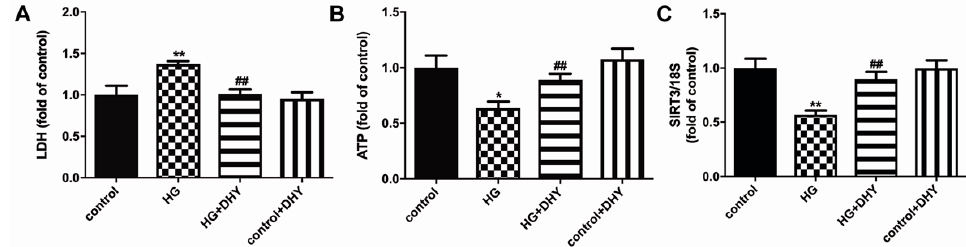
Figure 5. DHY attenuated cell damage but improved SIRT3 expression in cardiomyocytes with high glucose stimulation. ( A ) LDH in the culture medium. ( B ) ATP level in the cardiomyocytes. ( C ) Expression of SIRT3 mRNA in the cardiomyocytes. * p < 0.05, ** p < 0.01 versus control; ## p < 0.01 versus HG, n = 6.